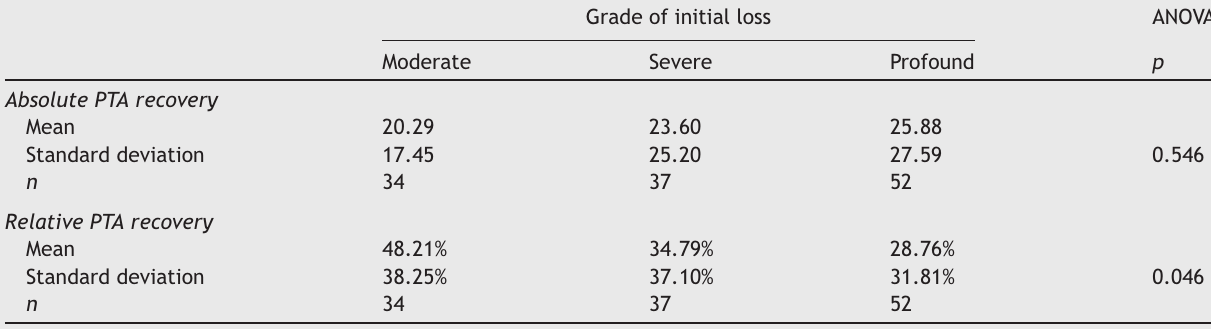
ANOVA tests among grades of initial loss for recovery